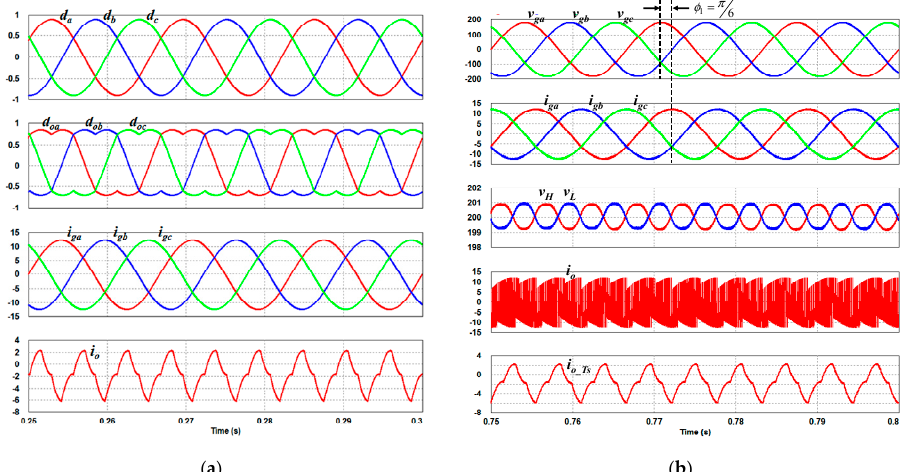
Figure 8. Simulation waveforms at non-unity power factor operation under unbalanced load conditions. ( a ) Average model ( d a , d b , d c : original duties; d oa , d ob , d oc : final duties considering the SVM and o ff set voltage; i ga , i gb , i gc : grid currents; i o : neutral point current). ( b ) Switching model ( v ga , v gb , v gc : grid voltages; i ga , i gb , i gc : grid currents; v H , v L : DC-link voltage; i o : neutral point current; i o_Ts : averaged neutral point current in every sampling